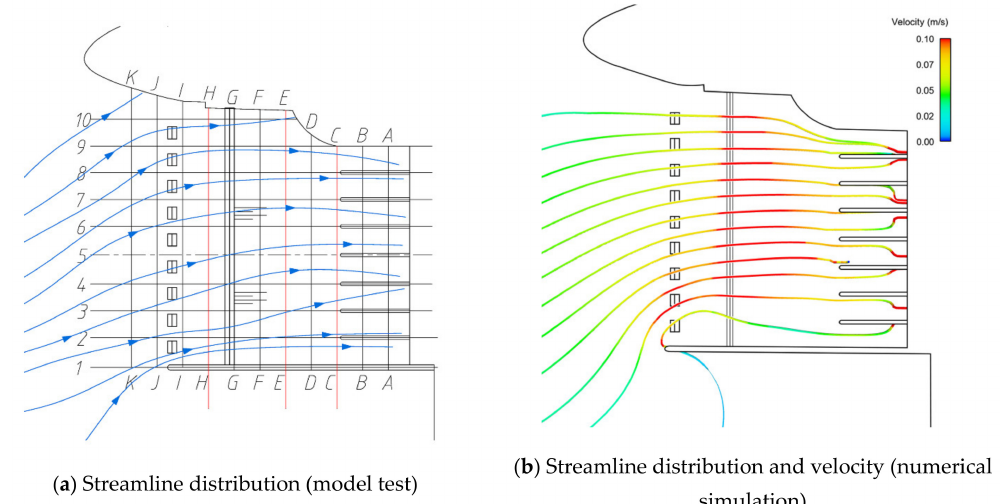
Figure 21. Plan 5 (maximum operating water level).